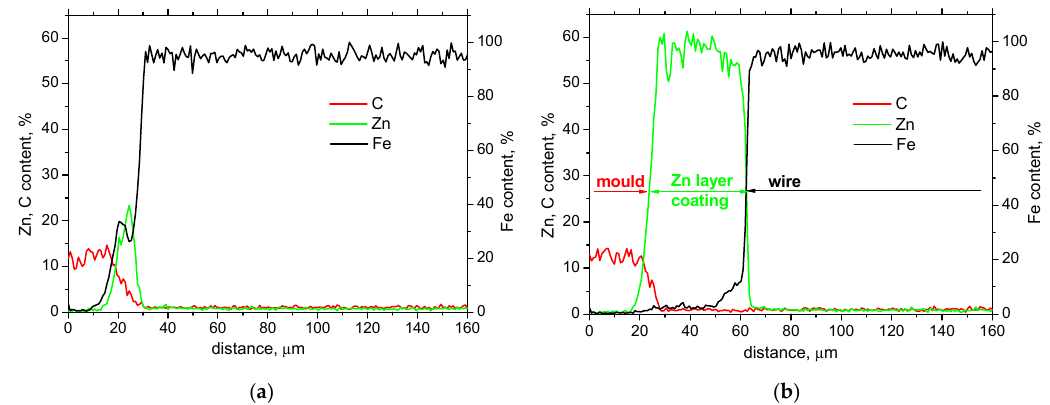
Figure 10. Linear chemical analysis of galvanized wire: ( a ) position 1, ( b ) position 4.